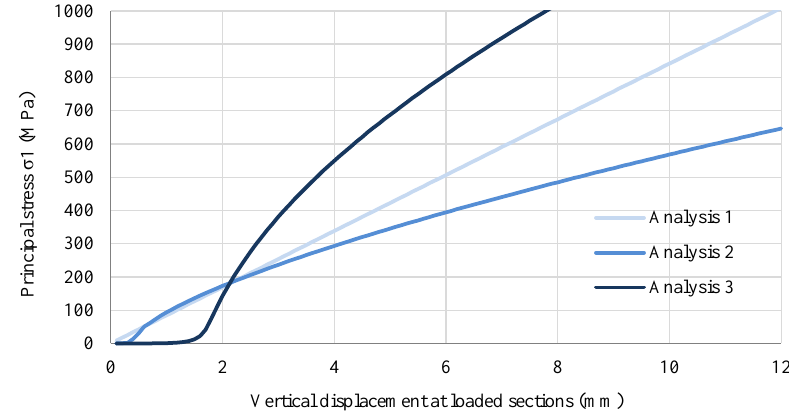
Fig. 7 Principal stress at critical points vs . vertical displacement at loaded sections for all three analyses